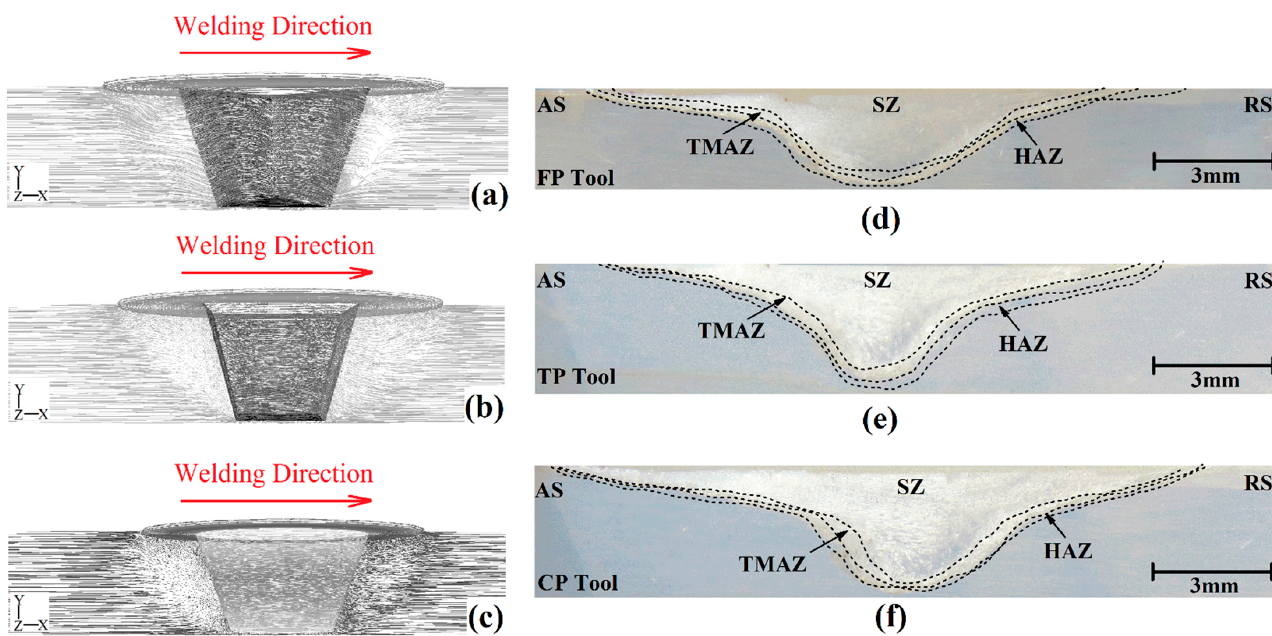
Figure 8. Simulation results of cross-section material flow at a joint FSWed by ( a ) FPT, ( b ) TPT, and ( c ) CPT pins. Cross-section view of a different joint area produced by ( d ) FPT, ( e ) TPT, and ( f ) CPT pins.